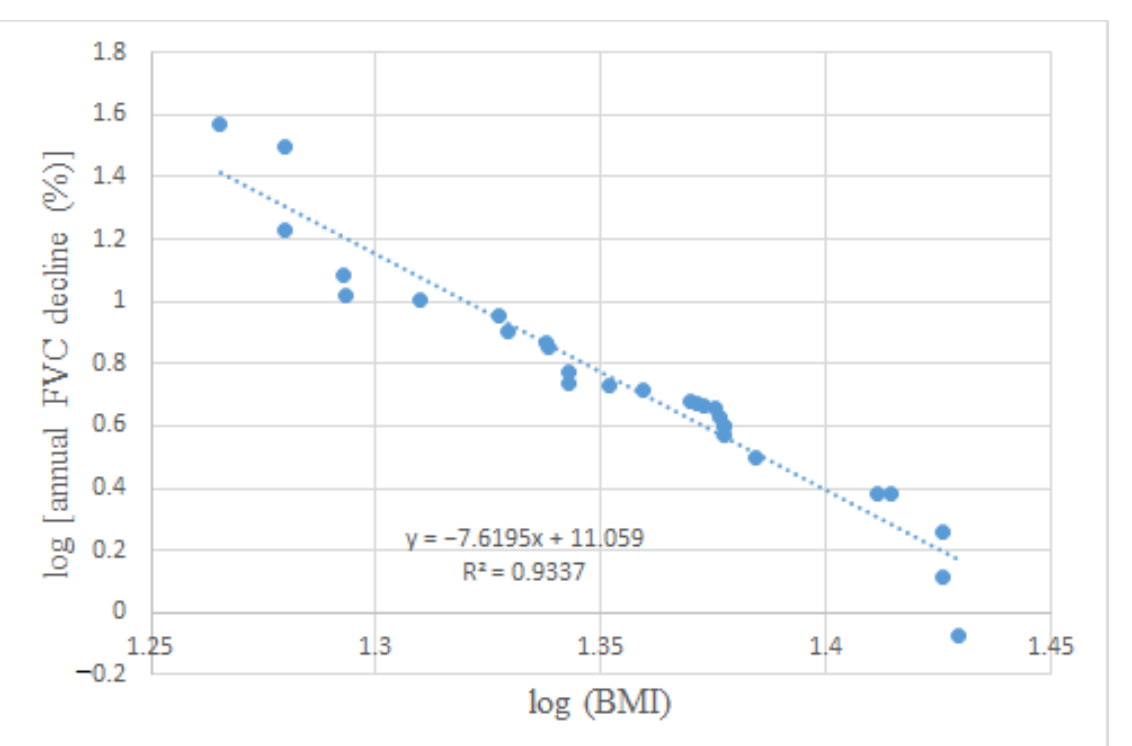
Figure 4. Negative correlation between BMI and annual FVC decline (%) . BMI, body mass index; FVC, forced vital capacity.